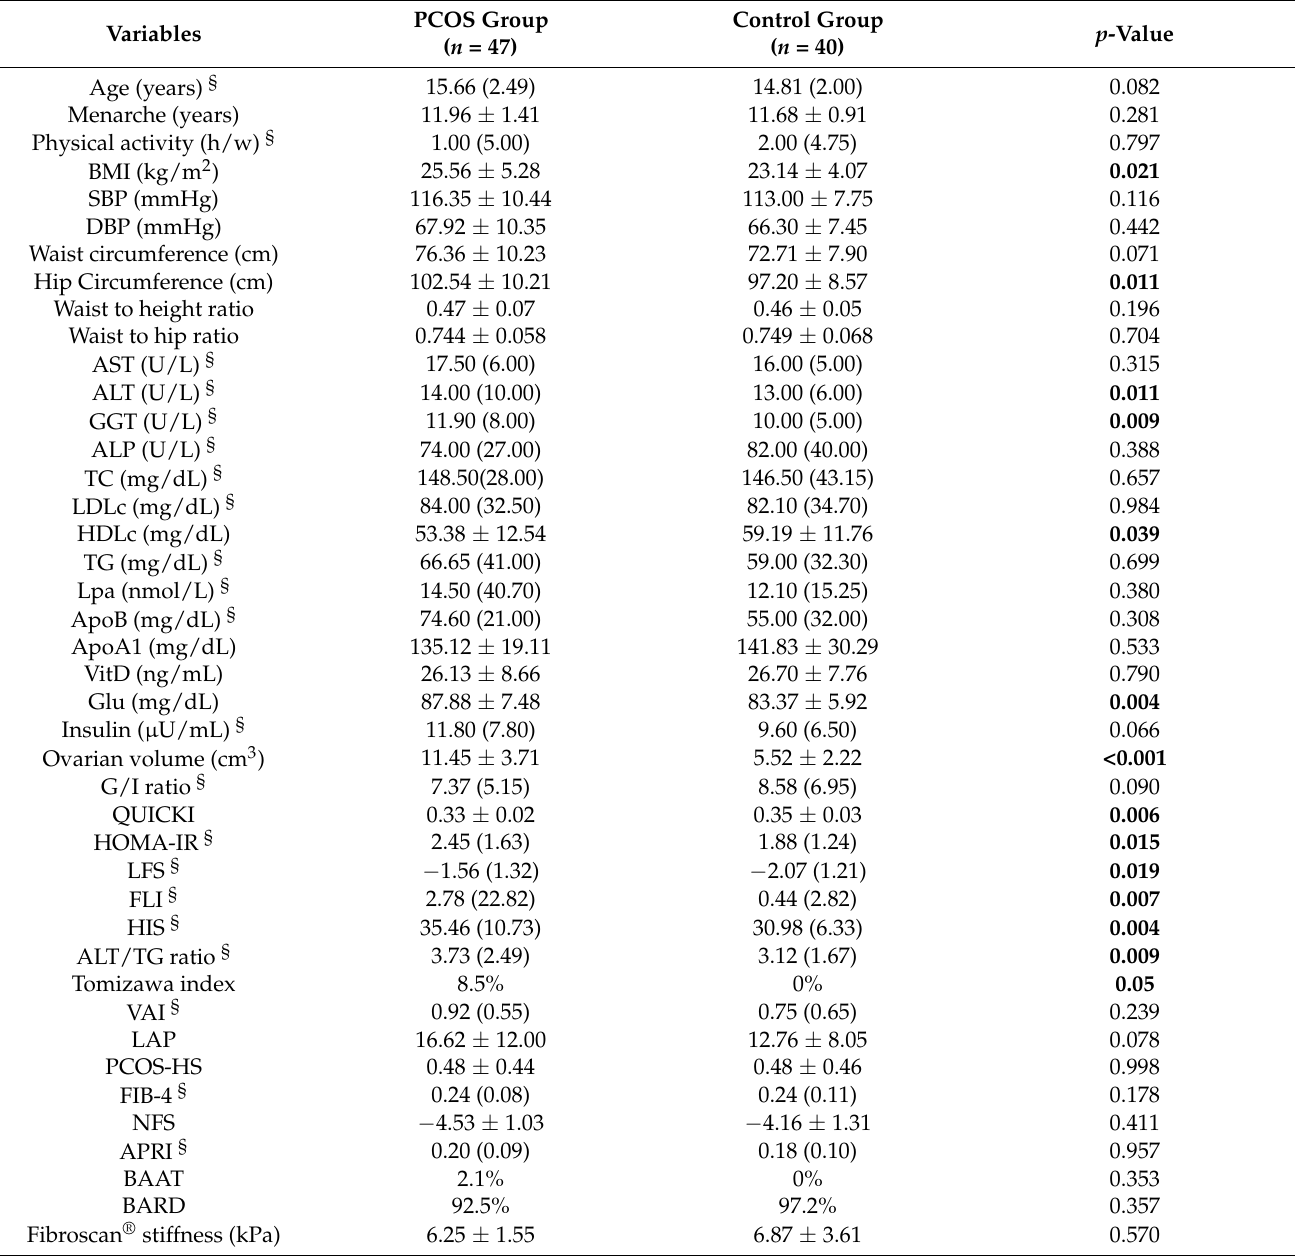
Table 2. Demographic and anthropometric data, biochemical and hormonal parameters, and IR, steatosis, and fibrosis indices (as continuous variables) of PCOS and control